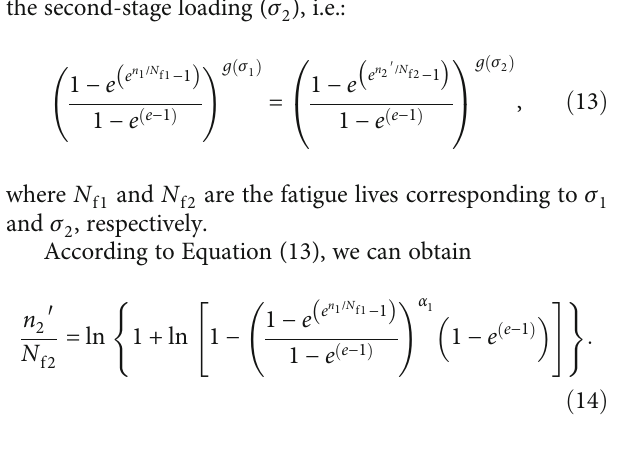
Figure 6: Relationships between cycling ratios of the 30NiCrMoV12 alloy steel under two-level cyclic